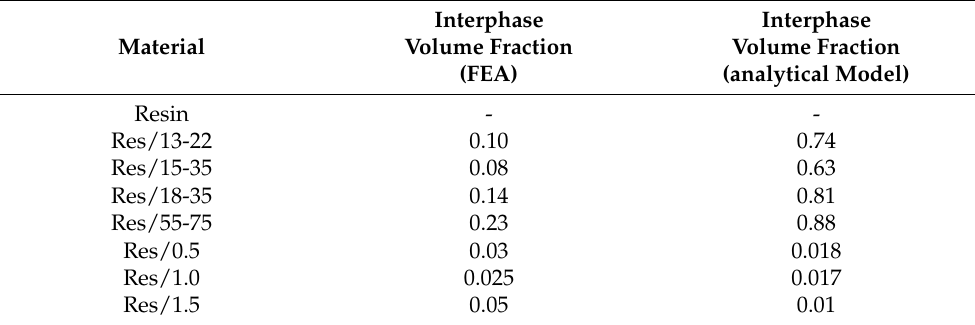
Figure 10. Young’s modulus with varying particle radius, at various values of the interphase thickness. Points: Experimental results, Lines: Analytical model. Table 5. Interphase volume fraction calculated by FEA and the analytical model.